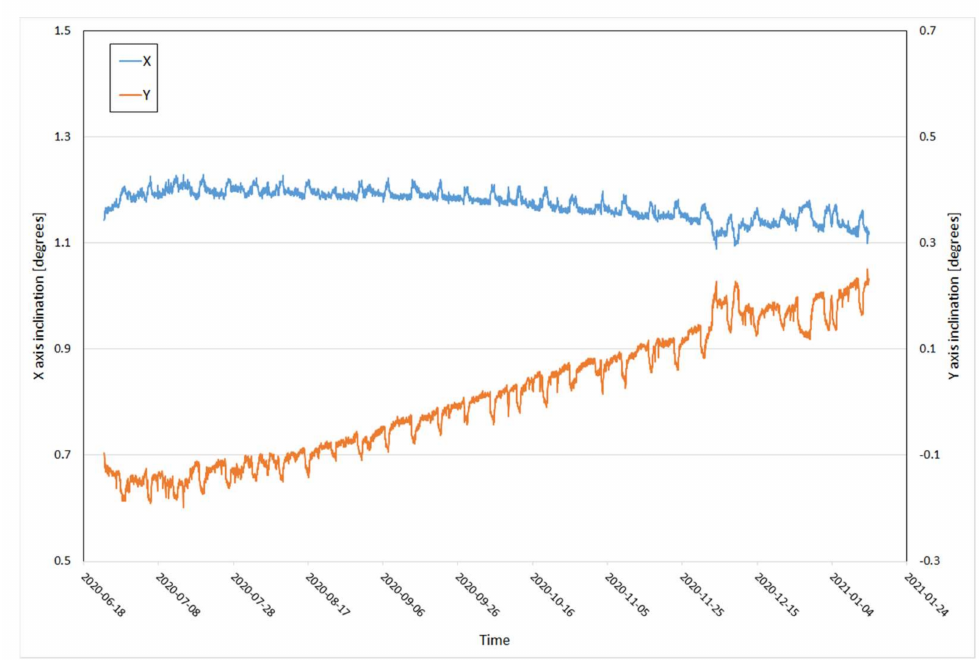
Figure 11. Changes in the slope (X and Y components) recorded by the CNS 221 sensor in the SI-XI/4